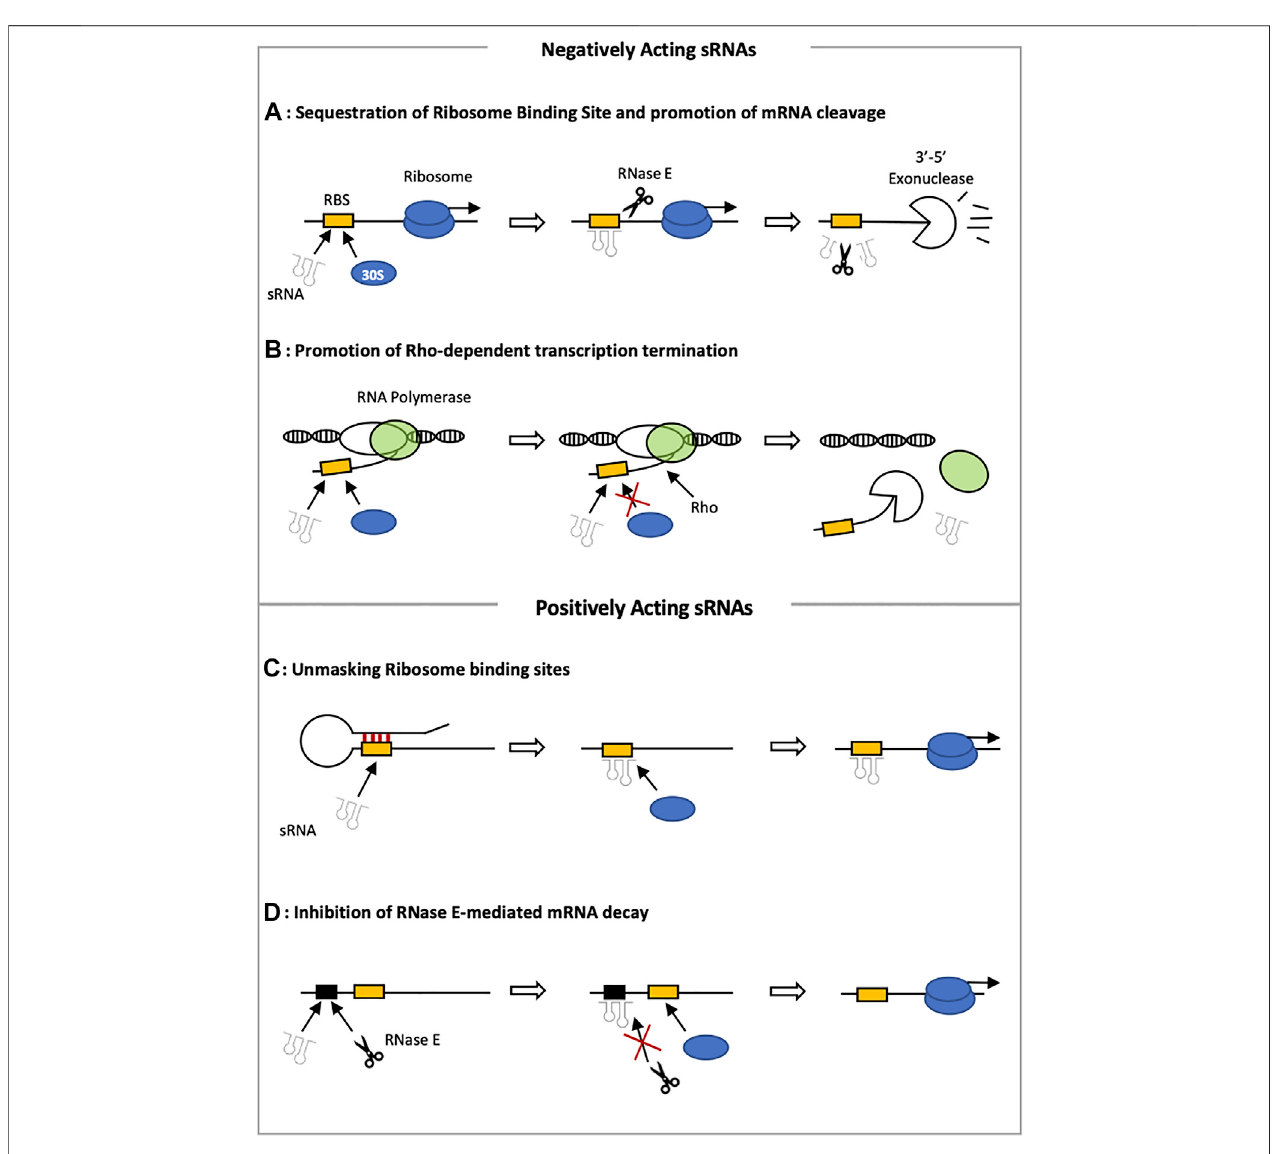
FIGURE 1 | Mechanisms of sRNA induced gene repression and activation. (A) When the sRNA target sequence overlaps with the ribosome binding site (RBS) translation initiation is blocked. This leaves the RNA more susceptible to RNase-mediated decay. (B) Alternatively, sRNAs can enhance Rho-binding and subsequently cause premature termination of transcription. (C) Positively acting sRNAs can bind to hairpin-like structures in their target, causing conformational changes to expose a previously inaccessible RBS and stimulate translation initiation. (D) Lastly, sRNAs are able to mask RNase E sites to stabilize their target and activate expression.